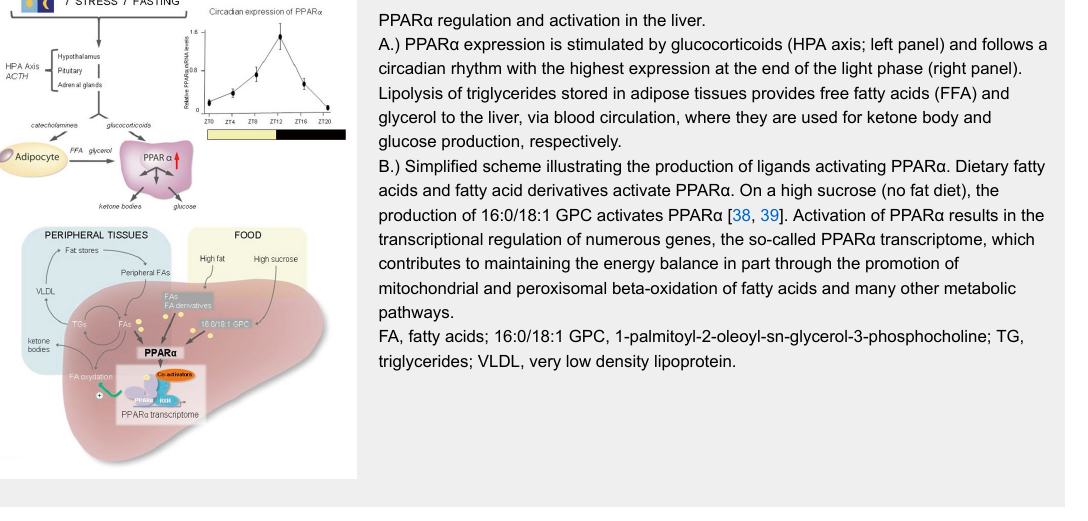
Anti-inflammatory effects of PPAR ligands. Cellular targets of the anti-inflammatory actions of PPARs activated by both endogenous and synthetic ligands. Ligand-activated PPARs down-regulate or up-regulate diverse components of the inflammatory response. The PPARβ/δ ligands activate the co- repressor BCL-6, inhibit the activity of NF-κB and ERK1/2 and induce anti-inflammatory and antioxidant genes. At the site of inflammation, PPARβ/δ ligands reduce the levels of adhesion molecules (ICAM-1, VCAM-1, E-selectin), pro-inflammatory cytokines (TNFα, IL-6, IL1β, IFNγ), chemokines (MCP-1, -3, -5, MIP1α) and chemokine receptors (CCR2). Furthermore, PPARβ/δ and its endogenous ligands are induced during the inflammatory phase of wound healing and promote keratinocyte migration and survival (Integrin-like kinase and Akt pathways). Antioxidant targets (SOD: superoxide dismutase, CAT: catalase, and thioredoxin) are also induced by PPARβ/δ ligands. The PPARα agonists inhibit transcription factors NF-κB, AP-1, GATA, and NFAT, which mediate the induction of genes responsible for the development of inflammation and cardiac hypertrophy. Moreover, PPARα ligands (fibrates, WY14,643) inhibit the production of Th1 cytokines (IFN-γ, IL-2, IL-17) and induce that of Th2 cytokines (IL-10, IL-4, IL-5) by T cells. Th, T helper cell; (+) positive regulation; (-) negative